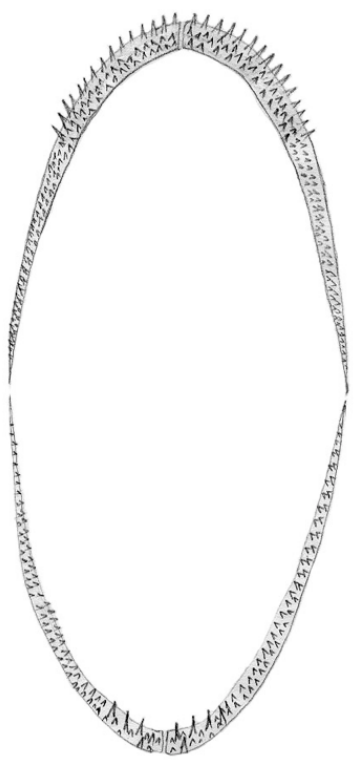
Figure 2. Dentition of Parambassis waikhomi, 36.3 mm SL